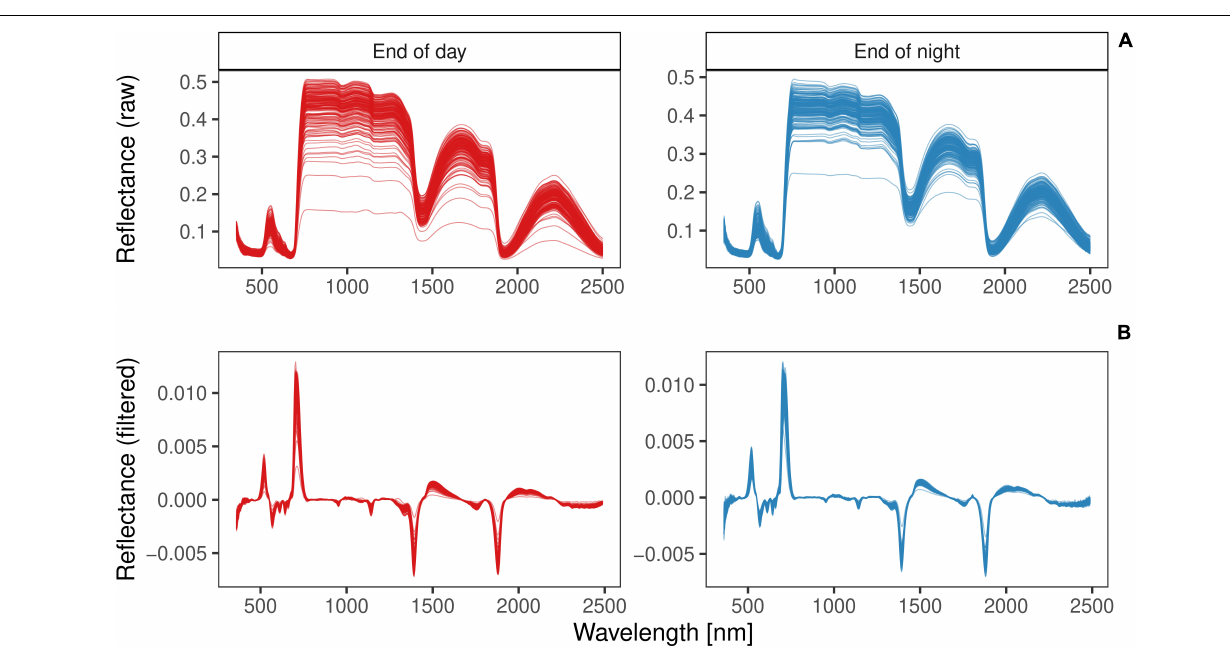
bands are in the regions near 1200, 1450, and 1950 nm